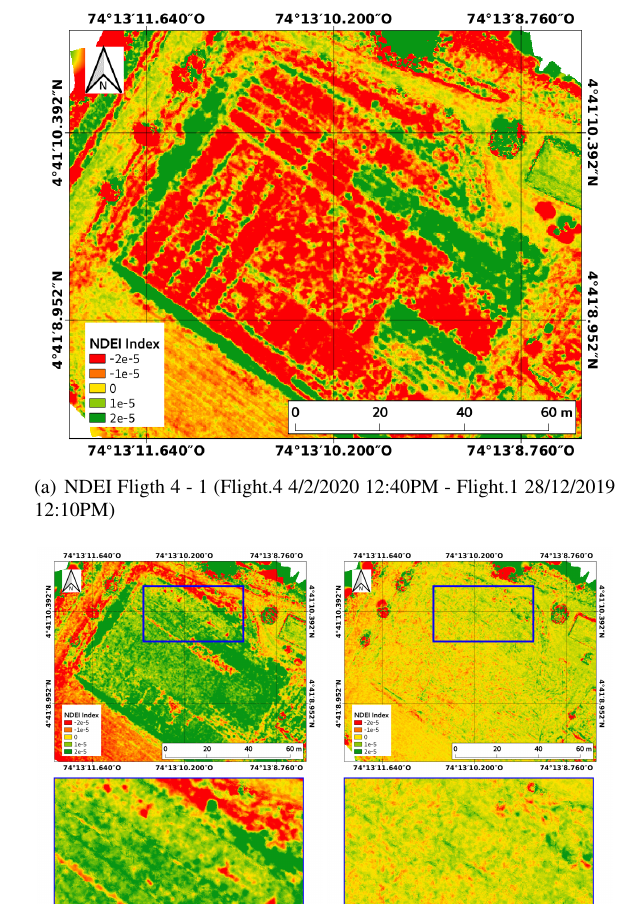
Table 4. GCPs RMSE - Flight 2 - 28/12/2019 1:25PM